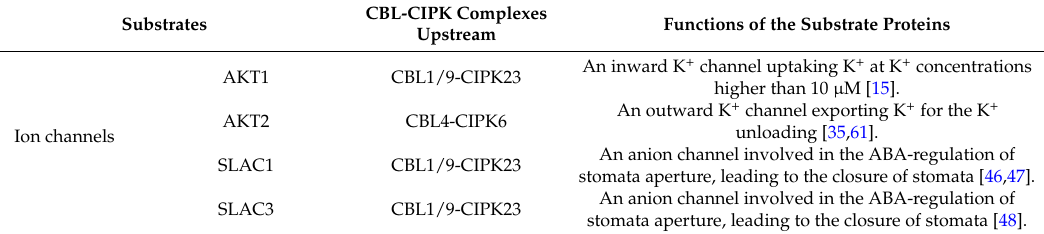
Table A1. Summary of reported substrates of CBL-CIPK